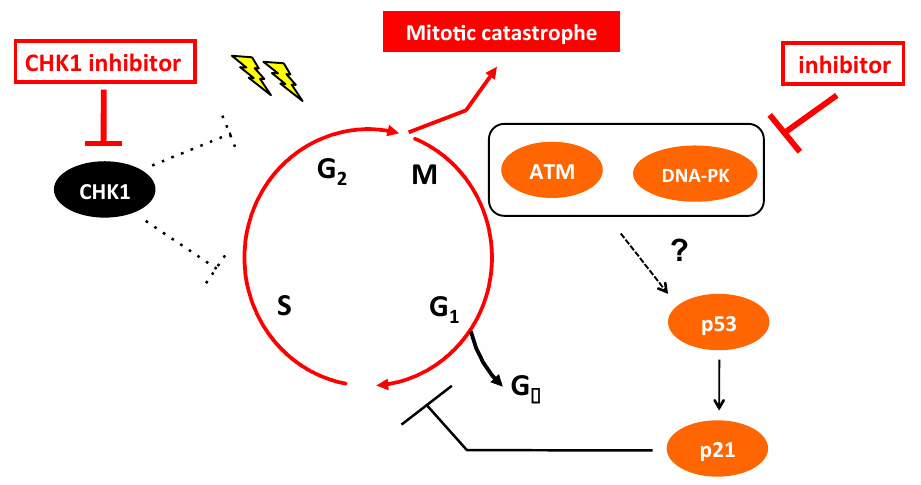
Figure 6. Blockade of the DDR enhances the therapeutic e ffi cacy of CHK1i in MYCN-amplified NB cells.